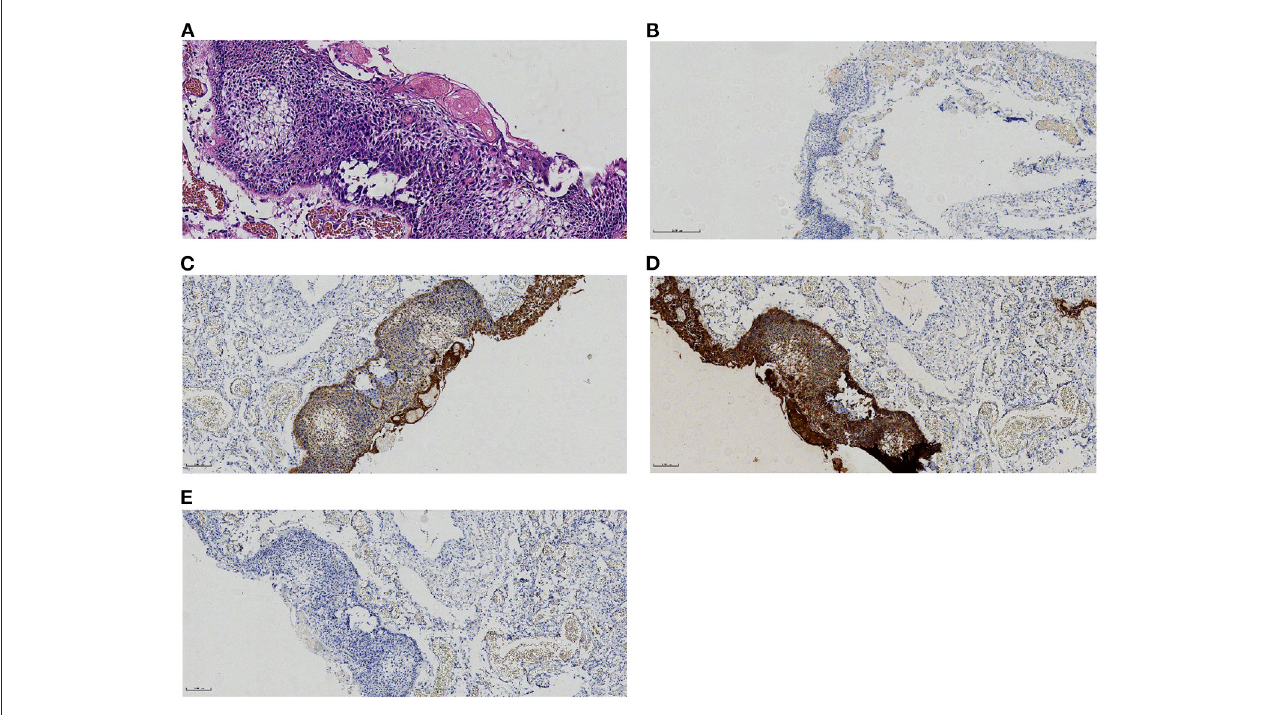
FIGURE2 Histological and immunohistochemical features of craniopharyngioma. (A) A microscope shows adamantinomatous cells and keratins. (B–E) Immunohistochemical staining for CEA-,CK + ,CK5/6 + ,GFAP- [Original magnification: (A) 200 × ; (B–E) 100 × ].